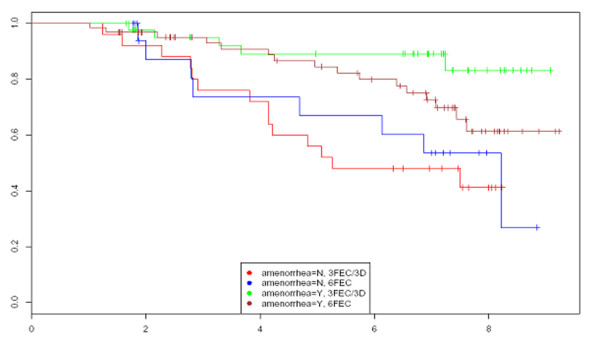
Kaplan Meier curves.